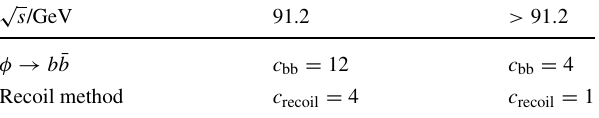
Table 1 The integrated luminosities per experiment, ferent stages of the LEP centre-of-mass energies, the comparison with the LEP results (see text) √ s /GeV 91.2